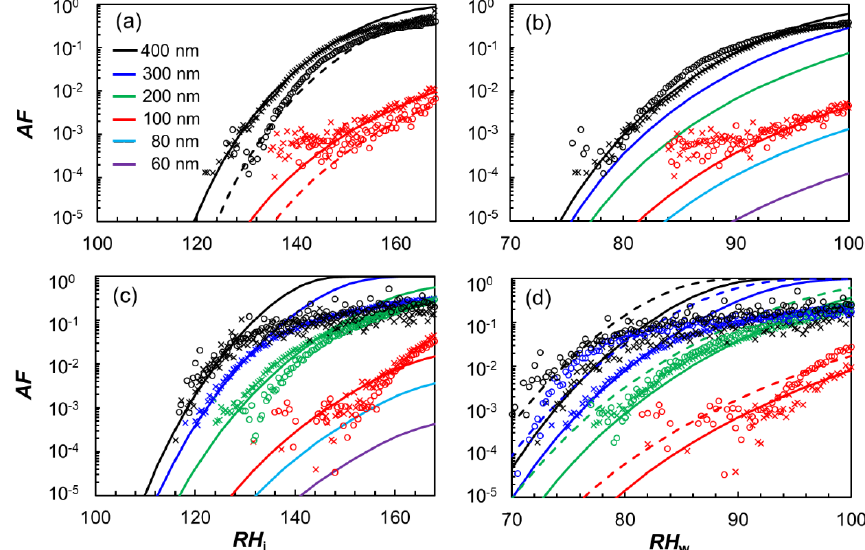
Figure 7. Fraction of soot particles that nucleate ice, termed activated fraction (AF; at temperatures of T = 218K (circles) and T = 223K (crosses)), as a function of relative humidity with respect to ice (RH i ; a, c ) and water (RH w ; b, d ) for (a, b) miniCAST black soot and (c, d) FW200 soot. The different colours denote soot aggregates of different electrical mobility diameters D m as indicated in the legend. Data are taken from Mahrt et al. (2018) for FW200 and from Mahrt et al. (2020b) for miniCAST black. The solid and dashed lines show the parameterization for 223 and 218K, respectively. Note that in the case of miniCAST black the curves at 218 and 223K coincide when plotted as a function of RH w , while in the case of FW200 the curves coincide when plotted as a function of RH i . See Appendix E for